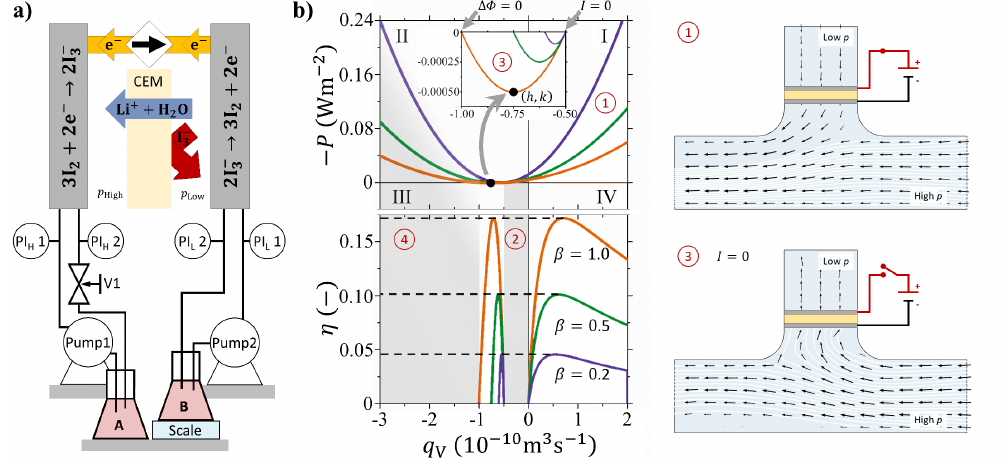
Figure 1. ( a ) Illustration of Electrokinetic Energy Conversion (EKEC) in a flow cell with two pumps circulating identical LiI/I 2 solutions from reservoirs through each half cell. The illustration depicts pump operation by current induced mass transport (electro-osmosis) towards the left-hand side of the system against a pressure load. Inlet and outlet pressures in each half cell are monitored and a needle valve is used to control the hydrostatic pressure difference ( ∆ p ) across the cell. On the opposite side of the system the reservoir is placed on a scale monitoring the mass transport through the cation exchange membrane (CEM). Charge balance between the two half cells is retained by opposite redox reactions in each half cell and the net effect is migration of Li + ions coupled to H 2 O-molecules through the CEM. ( b ) Illustration of the power density versus the volume flow ( q V ) through the CEM. The calculations have been performed with realistic membrane transport coefficients (see main text) and with ∆ p = 1 bar. The system is operated as a pump for P < 0 and q V > 0 (quadrant I), while power generation is for P > 0 and q V < 0 (quadrant III, also shown magnified in the